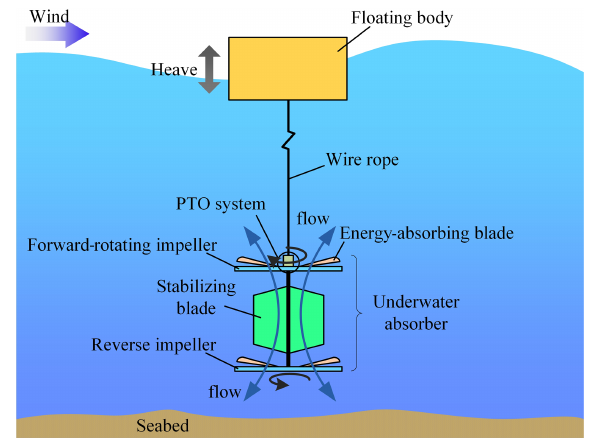
Figure 1. Schematic diagram of the working principle of a multi- body heave wave energy